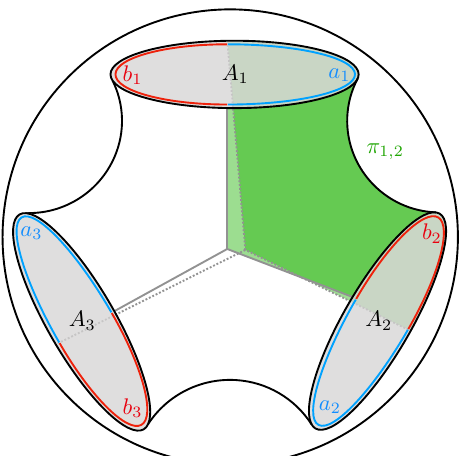
Figure 8 . A three-dimensional entanglement wedge for three boundary regions in the fully- connected phase. Its bounding RT surface must be partitioned into components that connect sequential pairs of boundary subregions, analogously to how geodesics connect pairs of boundary subregions in two dimensions. For illustration, the component π 1 , 2 connecting A 1 to A 2 is